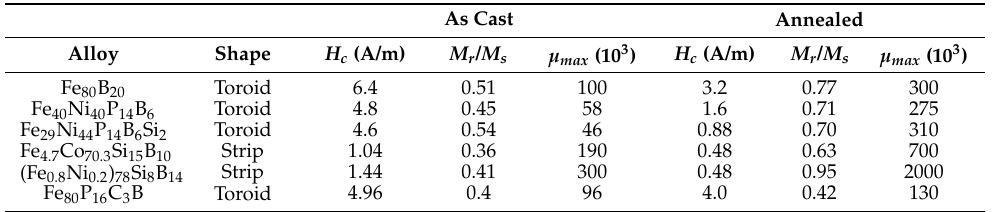
Table 1. Magnetic properties of amorphous alloys under direct current (DC) applications (reprinted with the permission from [30], CRC Press,